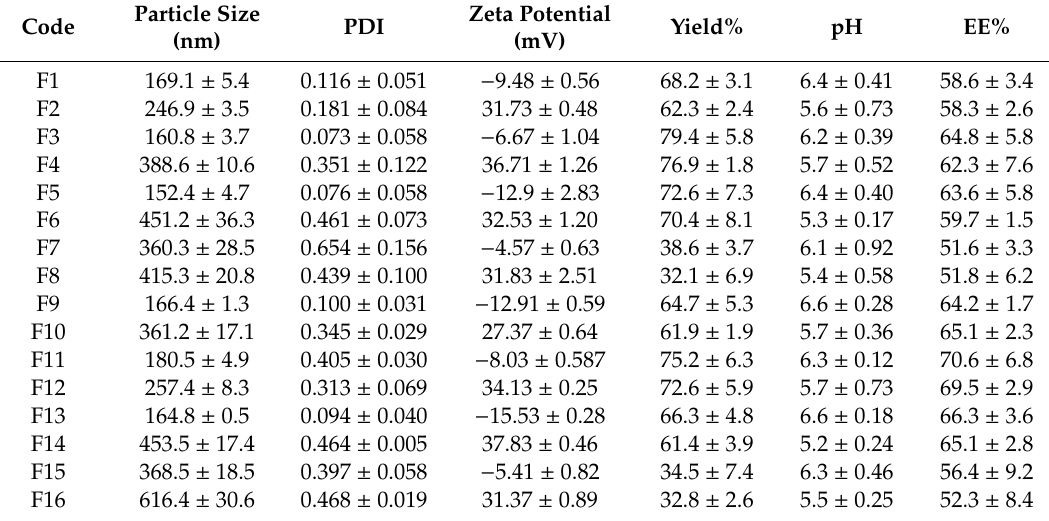
Table 2. Particle size, PDI, zeta potential, yield percent and EE% of PP loaded nanoparticles ( n = 3, ± SD).